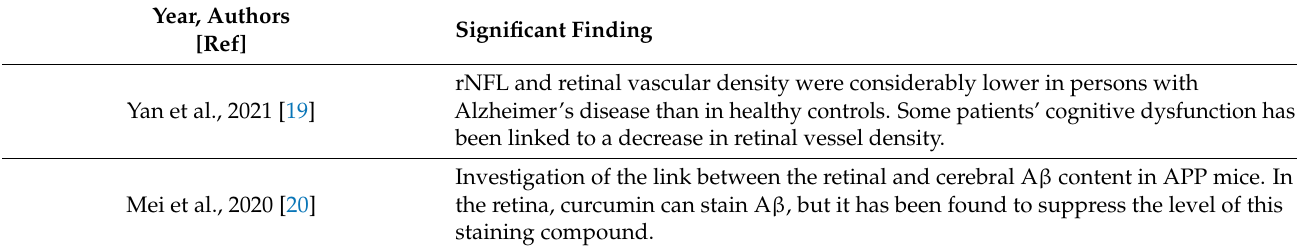
Table 1. Significant